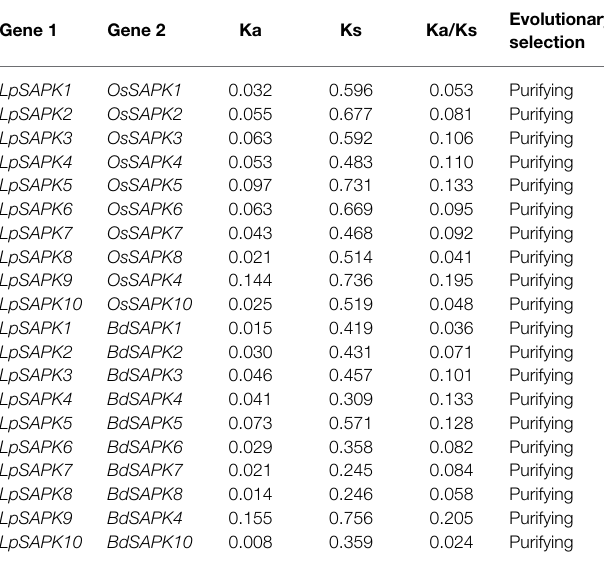
TABLE 1 | Purifying selection of LpSAPKs and their orthologous genes in rice ( OsSAPKs ) and brachypodium ( BdSAPKs ). Gene 1 Gene 2 Ka Ks Ka/Ks